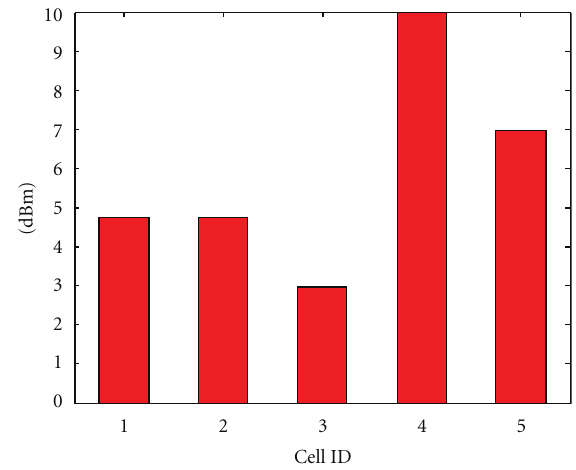
Figure 18: Load handled by the femtocells in exhaustive search (no. of FBSs = 5).